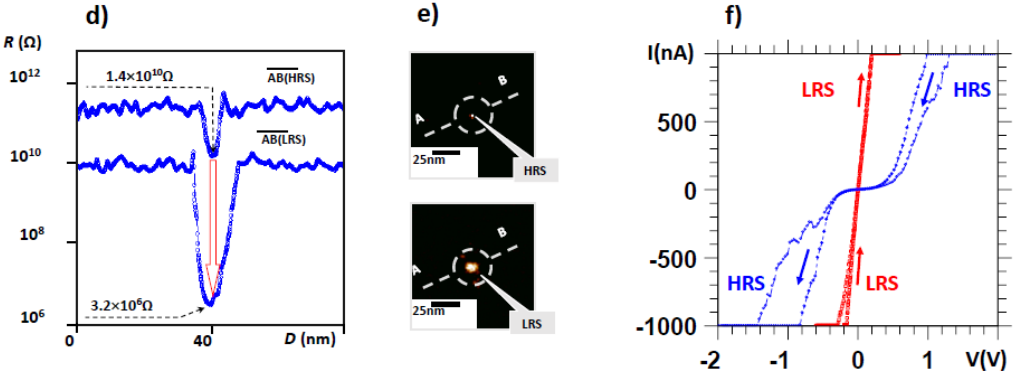
Figure 64. The electrical addressing of an individual dislocation in SrTiO 3 , using the tip of LCAFM, clearly demonstrated the possibility for a static manipulation of its resistance ( a – c ). For the dynamical